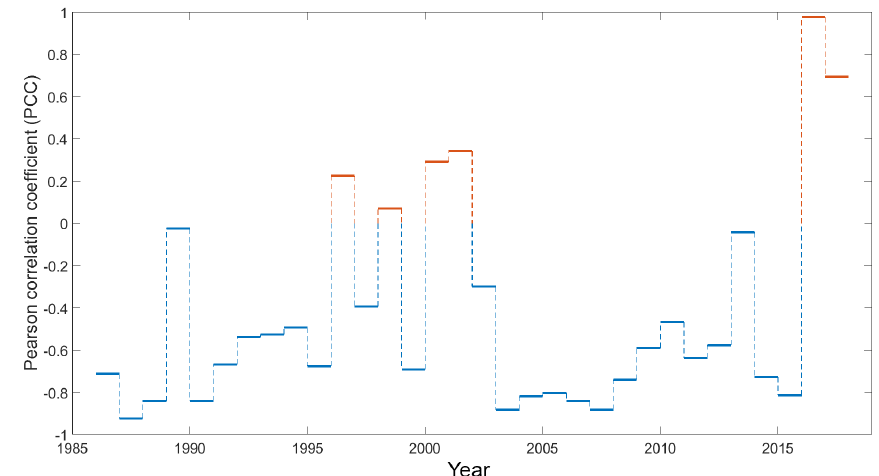
Figure 5. Pearson correlation coefficient between water levels and total production rates of each individual year of the time series. Generally, an inverse proportional correlation is obvious with an overall average for the whole time series of − 0.67. However, there are also years where a weakly to very strong positive correlation is present, especially in the time interval after the Kaikoura